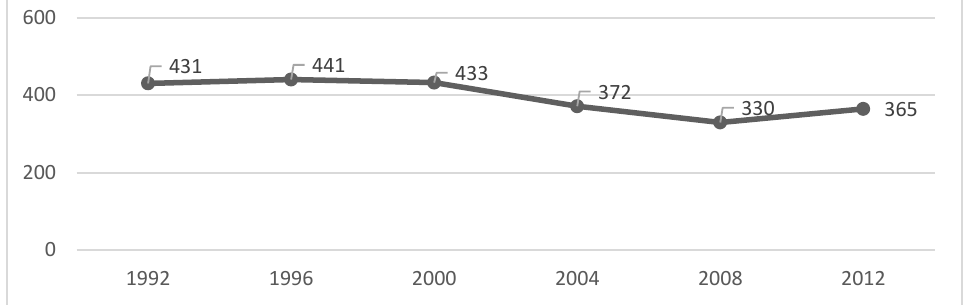
Figure 3. Bronze medals evolution over all the editions.